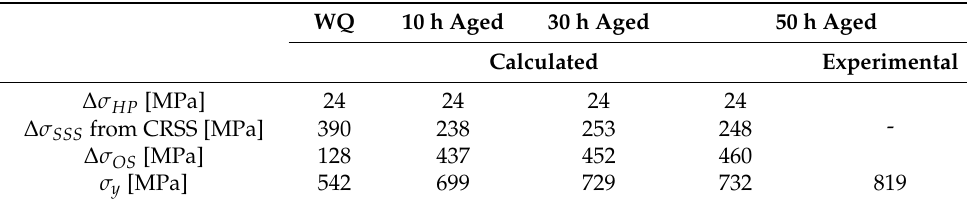
Table 2. Yield strength contribution from grain size ∆ σ HP (calculated with Equation (3)), from solid solution strengthening ∆ σ SSS (calculated from CRSS from computational methods), and from particle strengthening ∆ σ OS (calculated with Equation (2)), as well as the sum of the contributions σ y , for different states of the CCA compared to the experimentally determined yield strength for the 50 h aged state from the compression test.